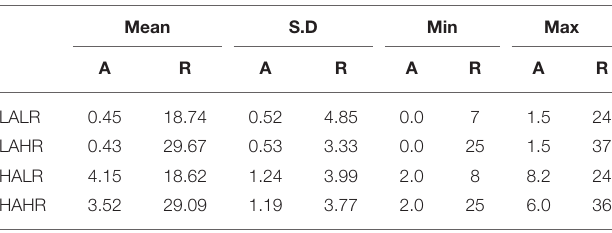
TABLE 4 | Altruism (A) and Reasoning ability (R) descriptive statistics by